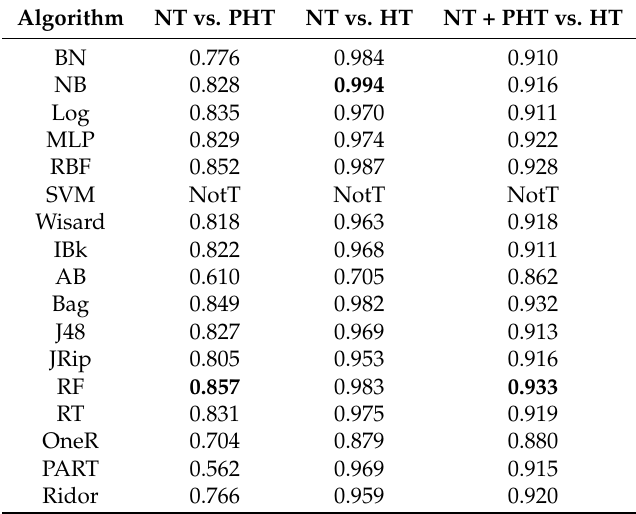
Table 6. Risk stratification performance for the different algorithms. NT, PHT, and HT represent normotension, pre-hypertension, and hypertension (type 1 and type 2 together), respectively. NotT means that the execution has not terminated within one week. The best performance for each risk level is evidenced in